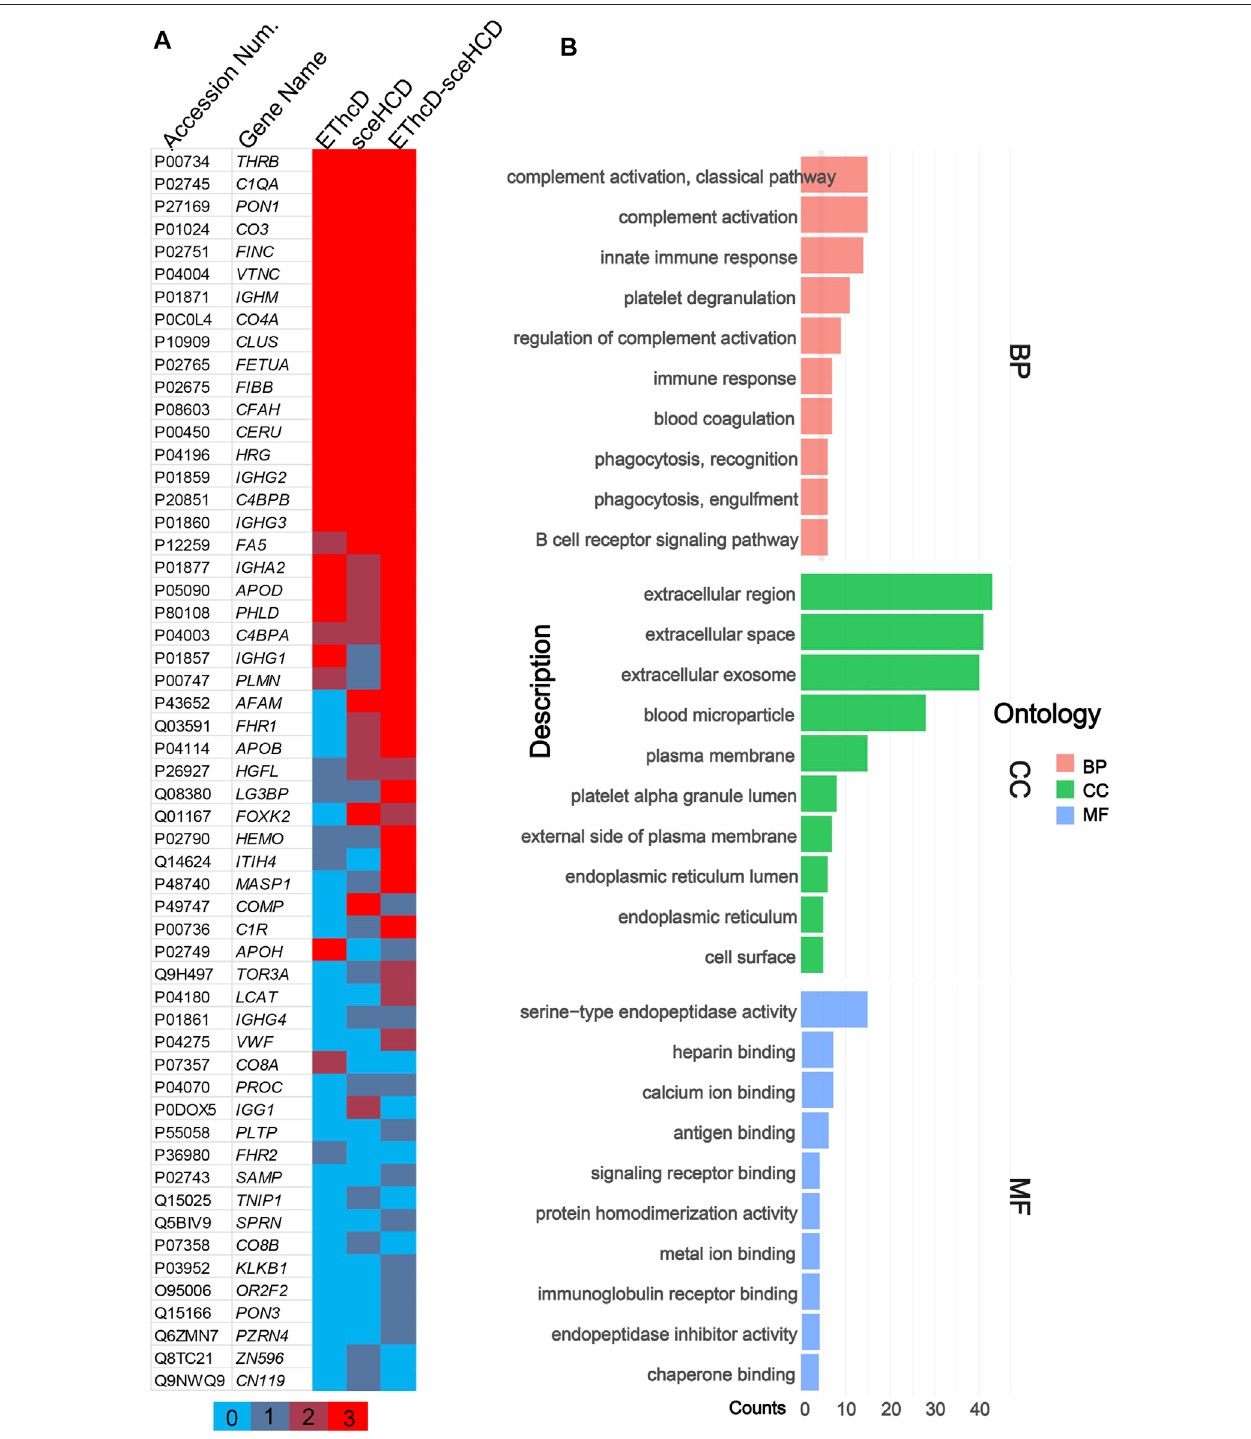
FIGURE 4 | Global analysis of identi fi ed plasma N-glycoproteins. (A) Heat map of identi fi ed plasma N-glycoproteins using different fragmentation modes. Colored lines indicate the number of repetitions identi fi ed. (B) Gene ontology (GO) biological process (BP), cellular component (CC), and molecular function (MF) enrichment